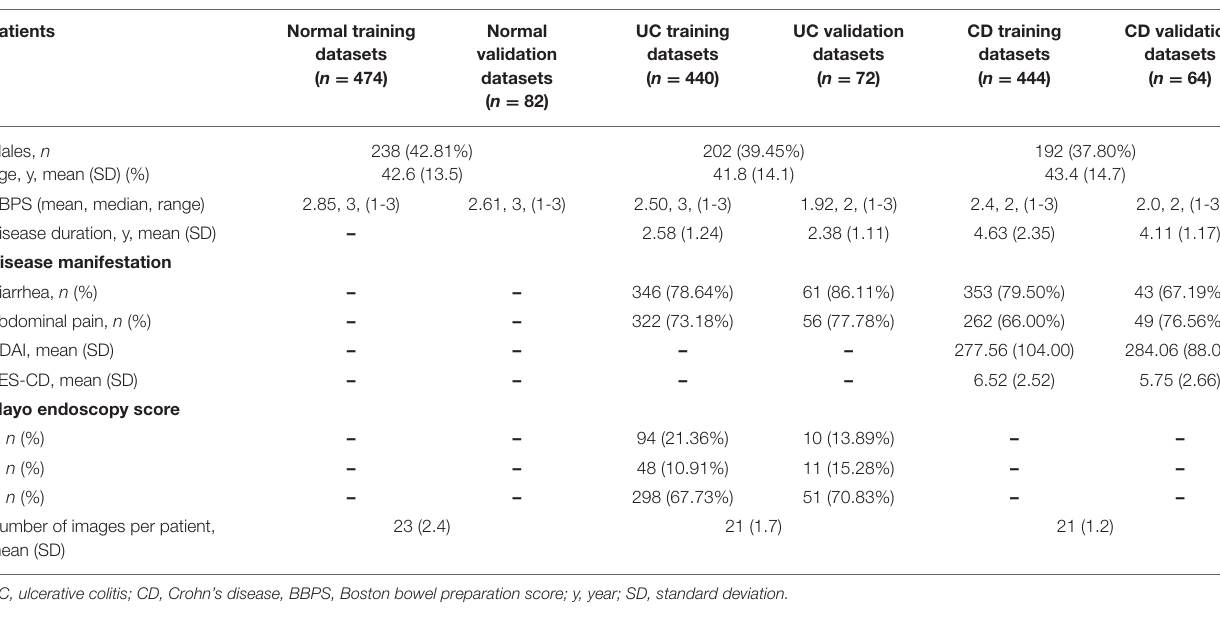
TABLE 1 | Patient and image characteristics in the training and validation datasets.